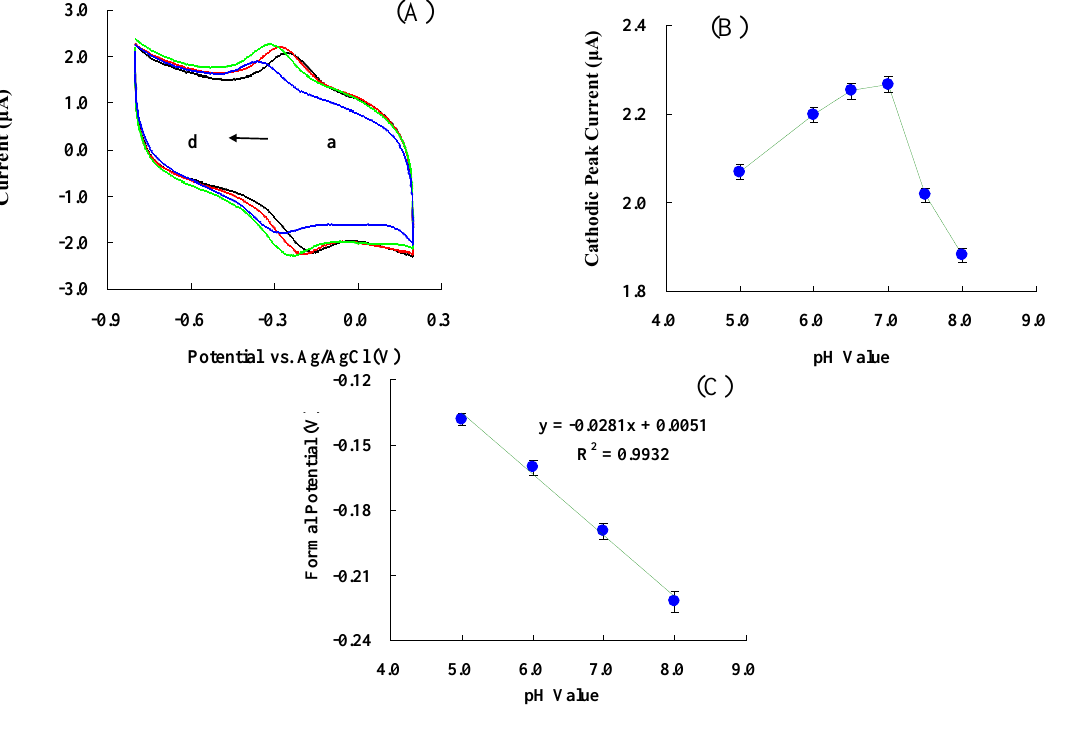
Figure 3. ( A ) CVs of NF/Hb/ FMWCNTs/Cys/AuNPs/GC electrode in 0.05 M PBS at different pH values: (a) 5.0, (b) 6.0, (c) 7.0, and (d) 8.0, respectively; ( B ) plot of I value; ( C ) Plot of Eº' vs . pH